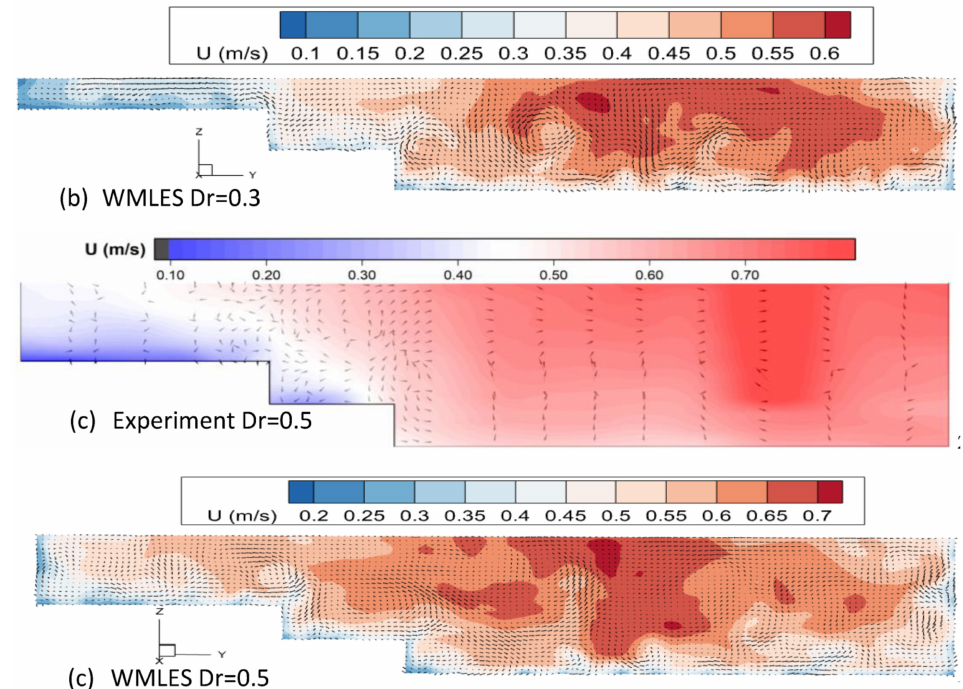
Figure 2. Contour mapping of the streamwise mean velocity for experimental and numerical results for three depth ratios as ( a ) Dr = 0.1, ( b ) Dr = 0.3 and ( c ) Dr =